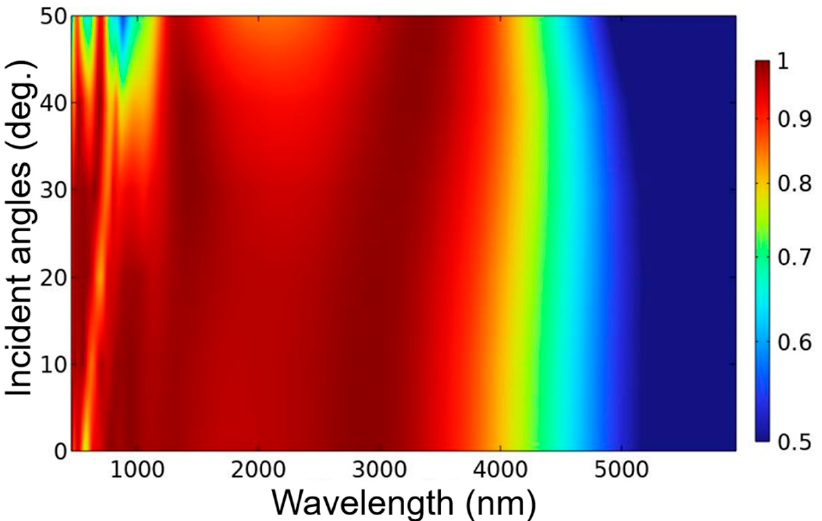
Figure 8. Evolution absorptivity of TE-polarized light with normal direction and different oblique incidence angles.